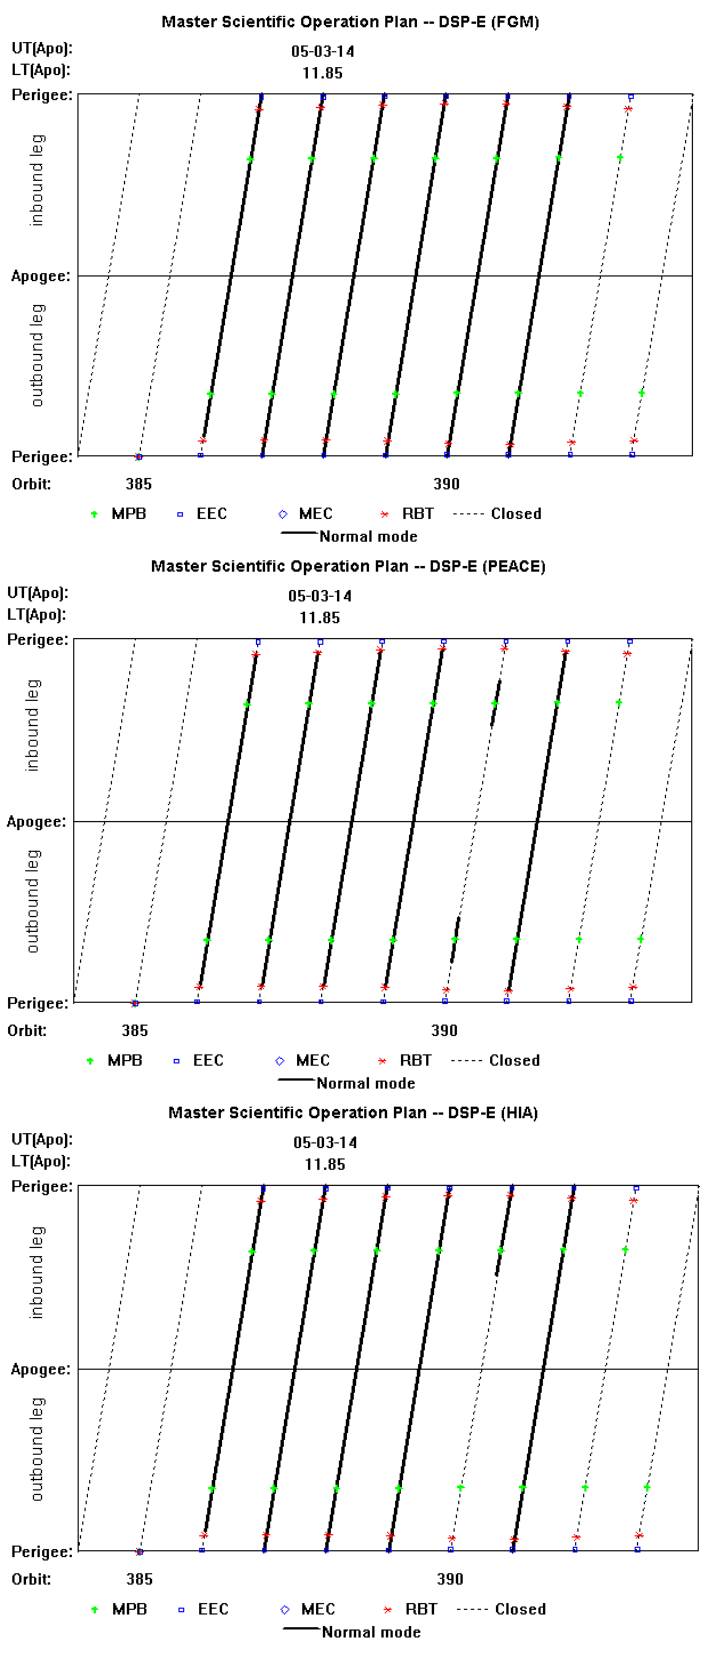
Fig. 9. The Bryant plots of the op- eration plans of FGM (upper panel), PEACE (mid panel) and HIA (lower panel) of TC-1 during the plan- ning period 65 (orbit 386–391) on 14–21 March 2005. In the Bryant plots, the operation of payloads for each or- bit has been illustrated as one lean- ing line segment starting and ending at the perigee, with the switched-on state denoted as thick black lines and the switched-off state as dashed ones. The horizontal axis is the orbit time marked by orbit numbers, the date and local time of the apogee have also been given above the upper horizontal axis, while the vertical axis shows the time of one orbit period with the apogee at the center. The operations plan of HEED/HEPD/HID is the same as that of FGM; the operations plan of ASPOC is the same as that of PEACE; the op- erations plan of STAFF is similar to that of HIA. The green crosses mark the magnetopause boundaries (MPB), red asterisks mark the boundaries of the ra- diation belt (RBT), and the blue squares and diamonds denote the Earth eclipse and Moon eclipse,